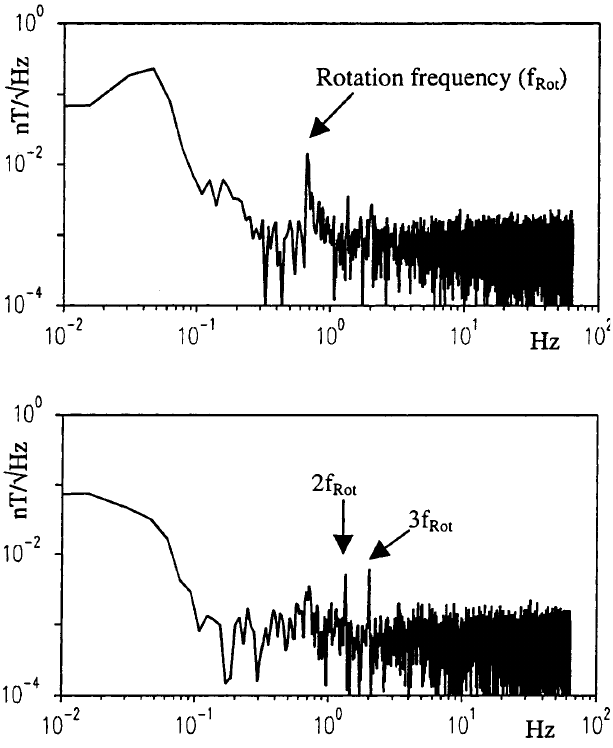
Fig. 6. Amplitude spectrum of a component perpendicular to the spin axis ( upper ) and amplitude spectrum of the field magnitude ( lower